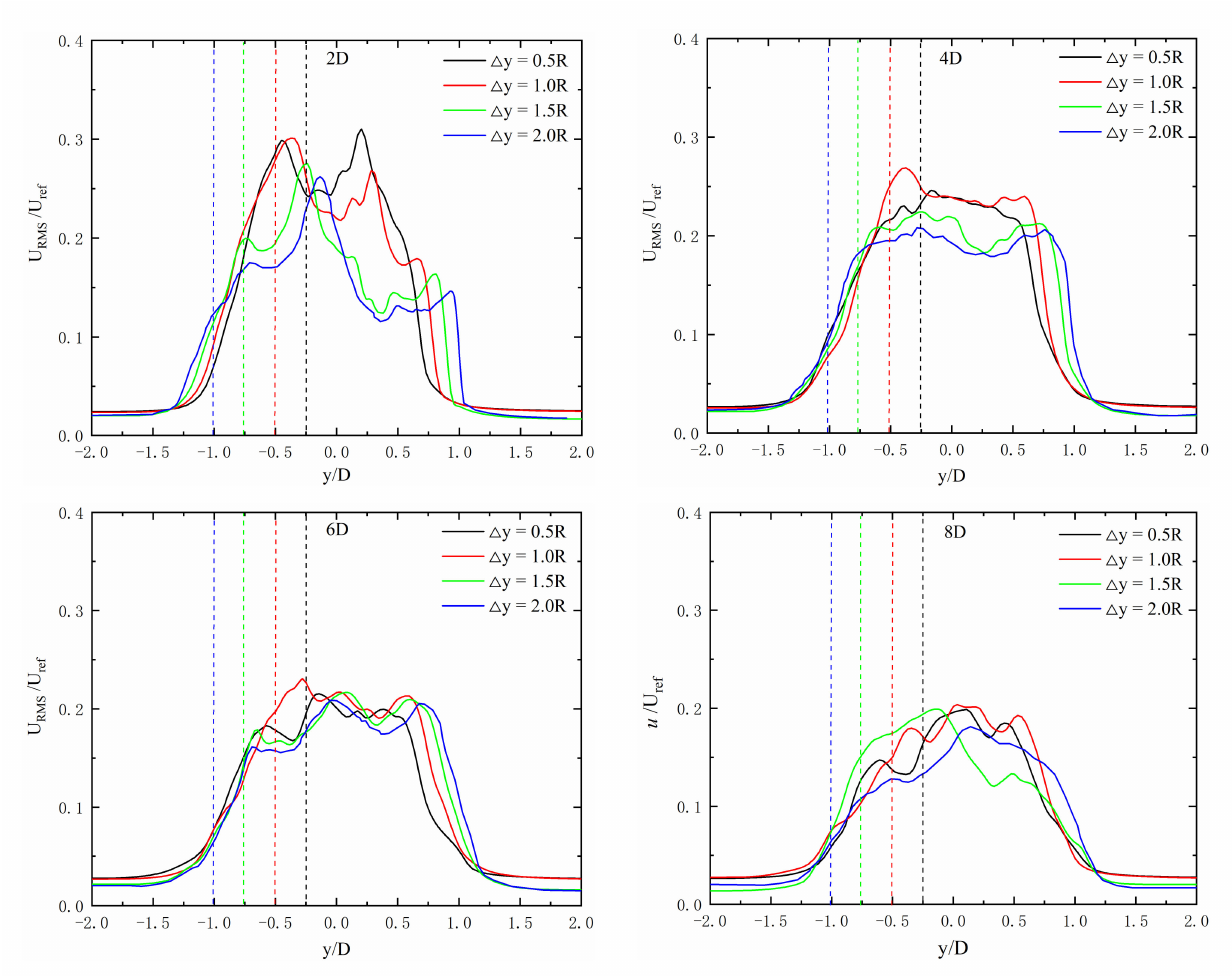
Figure 13. Turbulence behind WT-2 at different axial locations in the hub height. The dotted line represents the wake centerline of the WT-1 under each ∆ y (U ref = 11.4